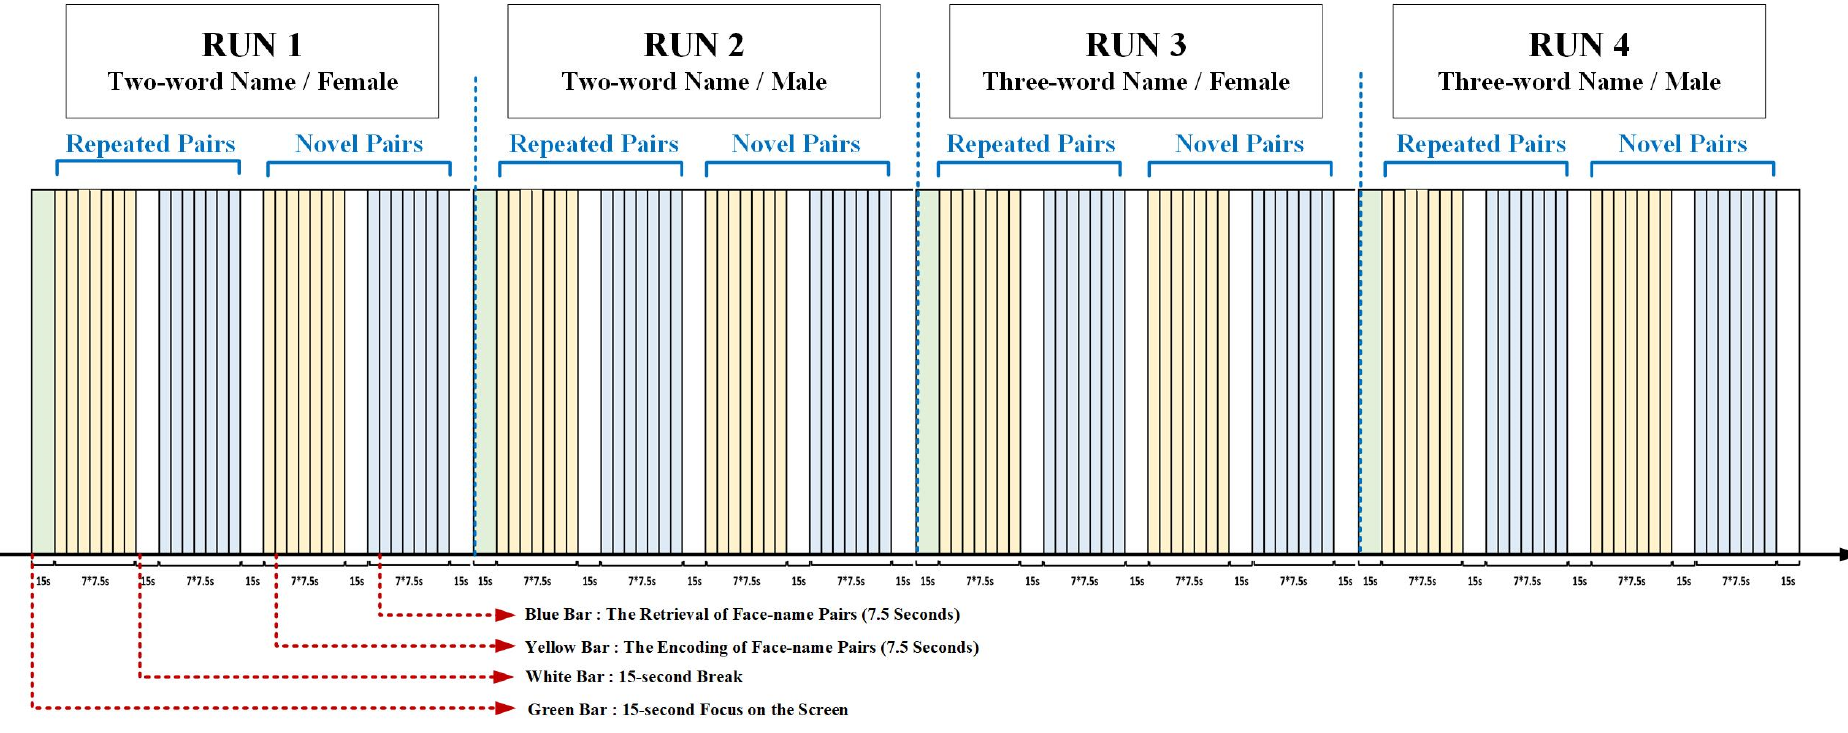
Figure 1. Face–name PAL Paradigm. Figure 1. face-name PAL